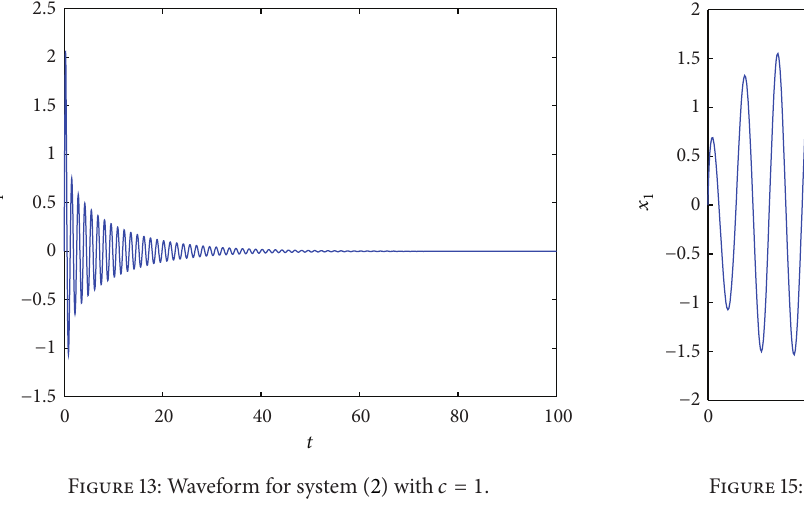
Figure 15: Waveform of system (2) with 𝑐 = 2.5 .